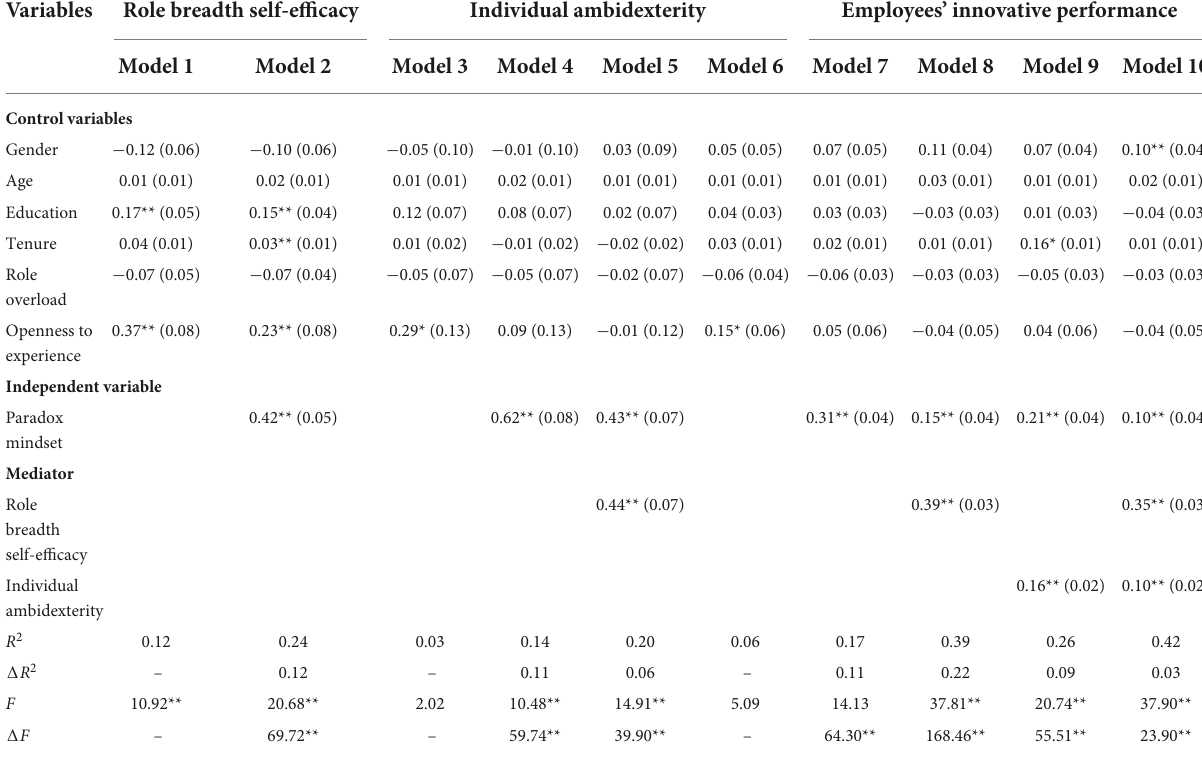
TABLE 4 Results of hierarchical regression analysis.